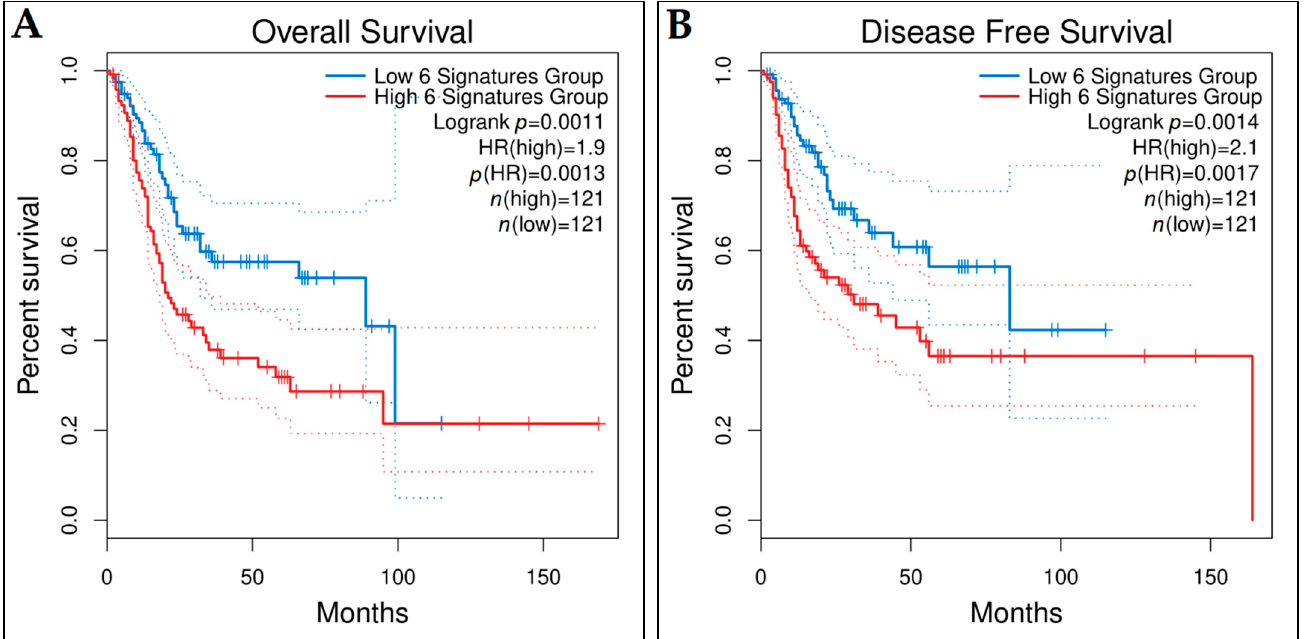
Figure 24. Kaplan–Meier survival plots of the six-gene predictive signature, generated using the GEPIA2 platform. Red and blue lines indicate the high- and low-expression patient groups, respec- tively. Patients were grouped ( n = 121 in each group) according to custom low and high cut-off values of 30% and 70%, respectively, for comparing their ( A ) OS and ( B ) DFS.